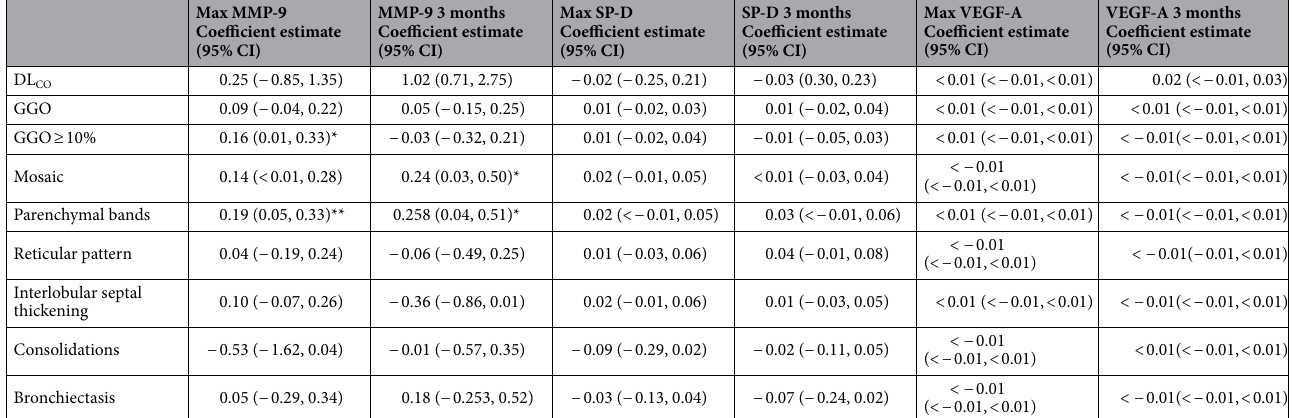
Table 5. Association of pro-fibrotic markers during hospital admission and after 3 months, with CT findings 3 months after hospital admission for COVID-19. GGO ≥ 10%, ground-glass-opacities in ≥ 10% of ≥ 1 lung zone. Mosaic, any mosaic pattern. Parenchymal bands, any parenchymal bands. Reticular pattern, any reticular pattern. Interlobular septal thickening, any interlobular thickening. Consolidations, any consolidations. Bronchiectasis, any bronchiectasis. MMP9 matrix metalloproteinase 9, SP-D surfactant protein D, VEGF-A vascular endothelial growth factor A, GGO ground glass opacities, CT computed tomography, DL CO in percent of predicted, GGO any ground-glass opacities. *p < 0.05, **p <